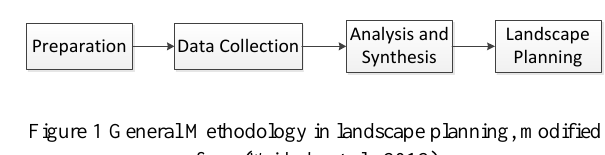
Figure 1 General Methodology in landscape planning, modified from (Widodo et al., 2012)